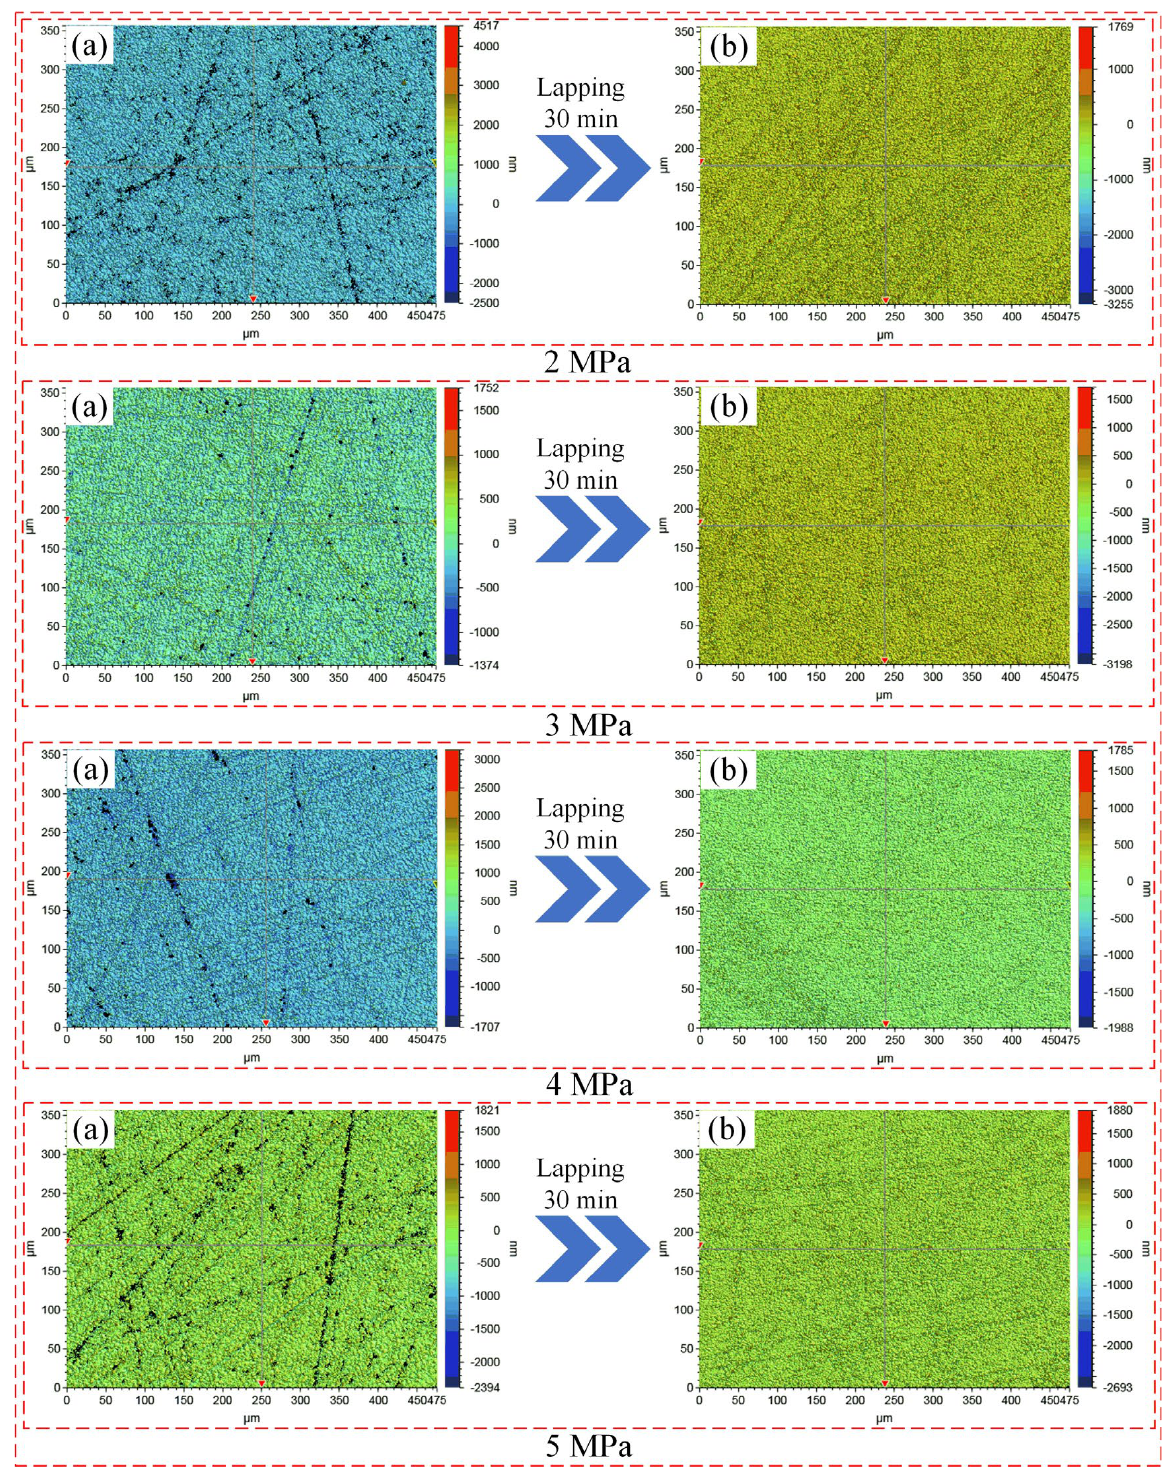
Figure 10. Workpiece morphology of FAP lapping with AWJ dressing under four pressures: ( a ) before lapping; ( b ) after